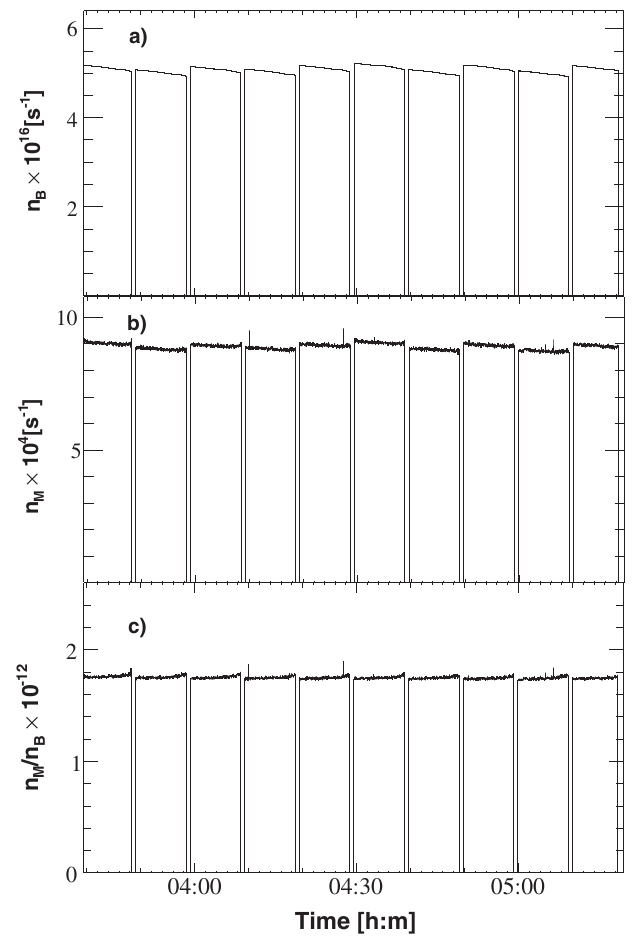
FIG. 8. (a) The BCT particle current n n , and (c) the ratio n M